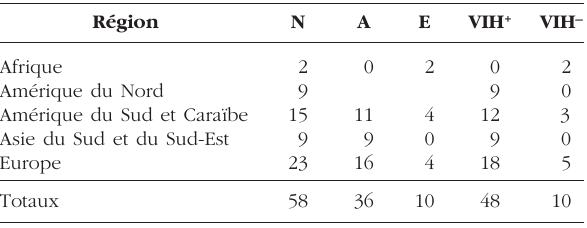
Tableau I. – Cas humains de cryptosporidiose due à Cryptosporidium felis rapportés dans le monde depuis 1999. femme âgée de 23 ans atteinte d’un lymphome (Guyot et al. , 2001) et un enfant âgé de huit ans atteint d’une affection héréditaire sévère (Pedraza-Diaz et al. ,